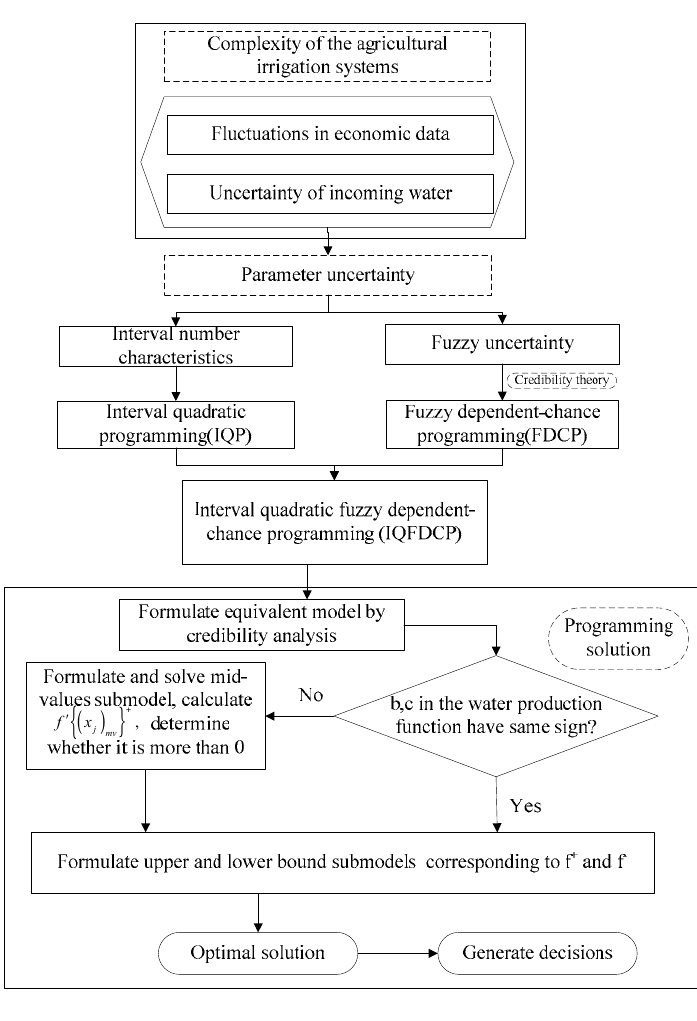
Figure 1. The framework of the interval quadratic fuzzy dependent-chance programming (IQFDCP) model.